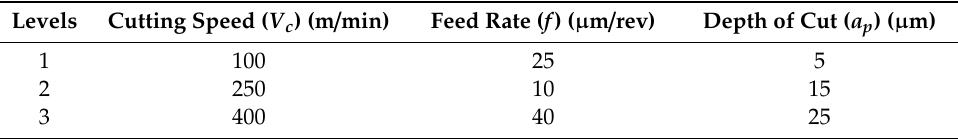
Table 3. Process variables used in cutting tests.